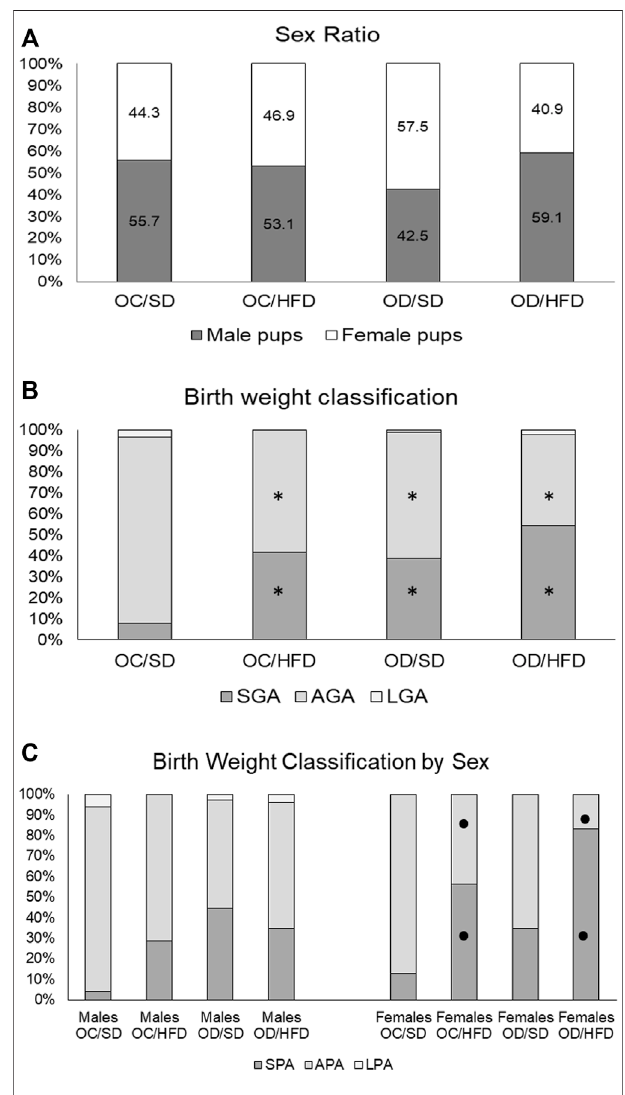
FIGURE 6 | (A) Sex ratio, (B) birth weight classi fi cation, and (C) birth weight classi fi cation by sex from OC, control offspring; and OD, diabetic offspring that received SD, standard diet or HFD, high-fat diet from weaning. Values are expressed in percentages. Legend: SPA — small fetuses for gestational age, APA — adequate fetuses for gestational age, and LPA — large fetuses for gestational age. * p < 0.05 — compared to OC/SD group (Chi- (cid:129) square test) and p < 0.05 — between male and female pups from the same group (Chi-square test).